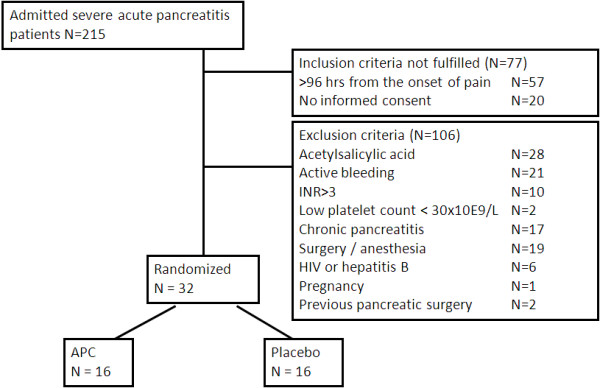
Flow-chart of the study.